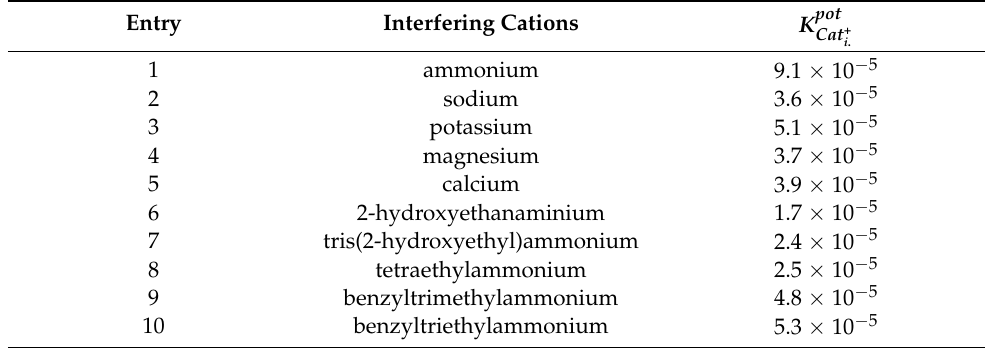
Table 2. Interfering influence of the selected inorganic and organic cations towards CPC.